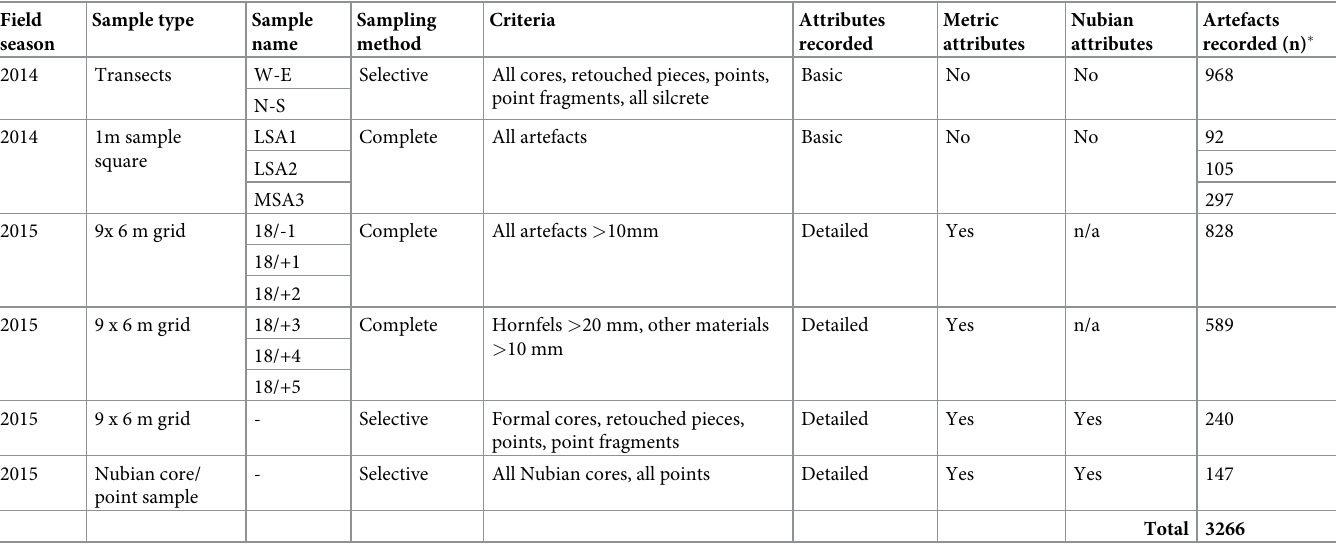
Table 1. Sampling and recording methods employed at